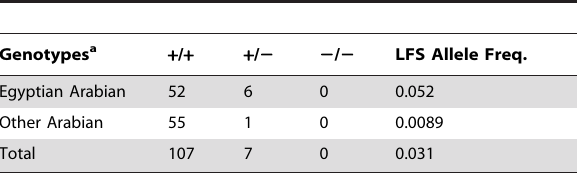
Table 3. Frequency of the Lavender Foal Syndrome associated deletion among a sample of Arabian